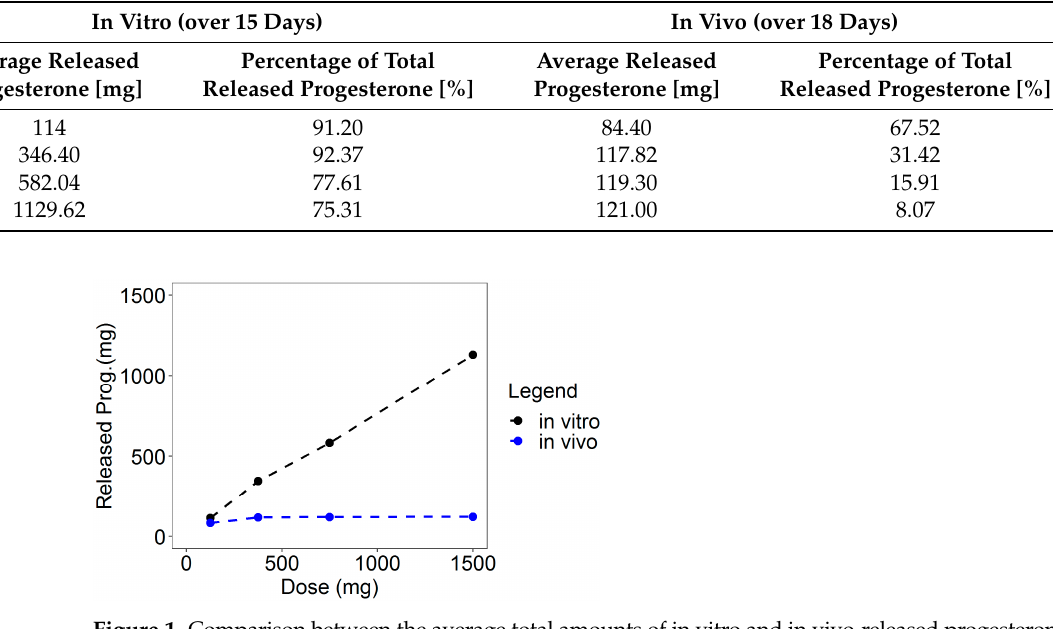
Table 3. Comparison between the total amount of released progesterone in vitro and in vivo.